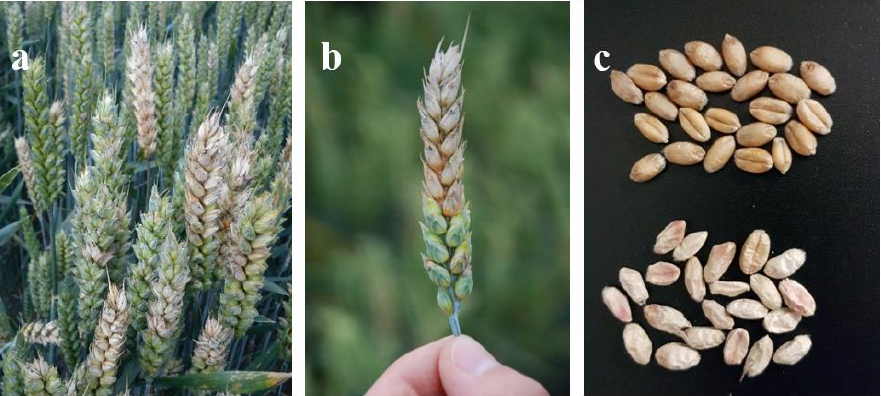
Figure 1. Symptoms of Fusarium head blight (FHB) of wheat. ( a ) Symptomatic heads with bleached spikelets. ( b ) Premature bleached head with pinkish-red mycelium and spores on infected spikelets. ( c ) Fusarium -damaged grain showing pink and white discolorations (bottom) compared to healthy grain (above).